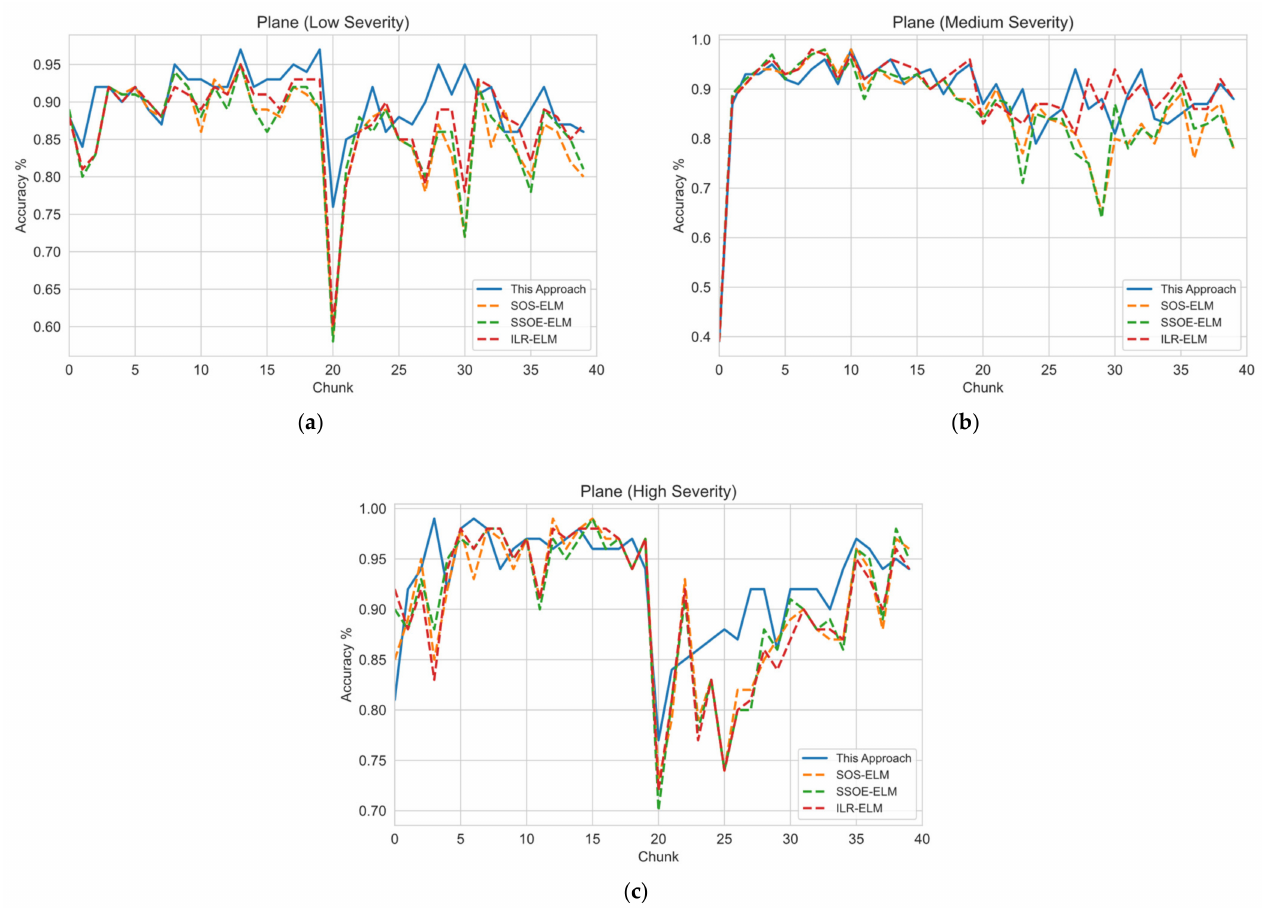
Figure 6. Plane dataset experiment on variable concept drift severity. ( a ) Performance on low severity dataset. ( b ) Performance on medium severity dataset. ( c ) Performance on high severity